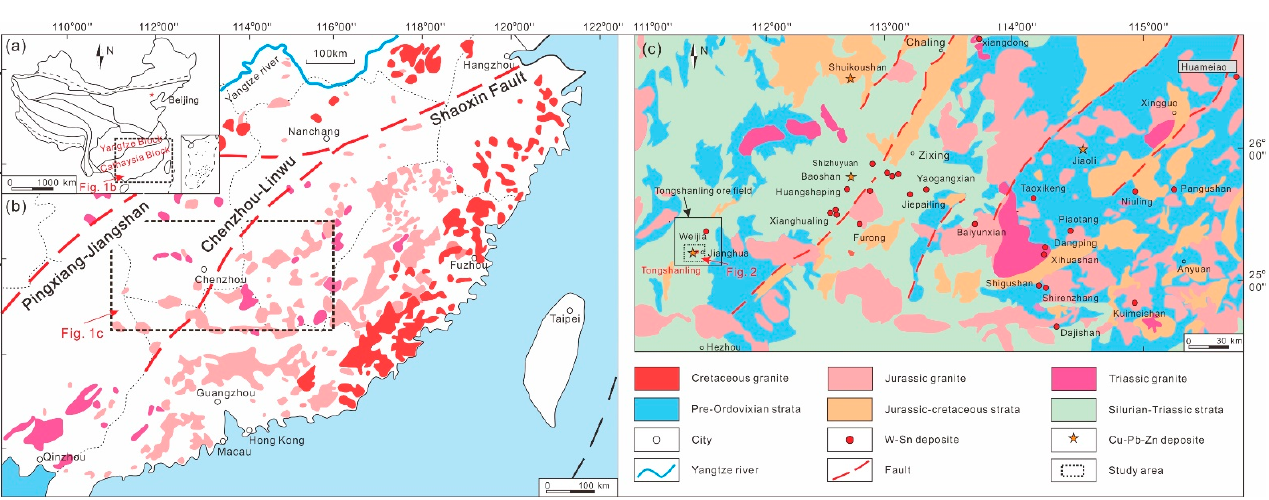
Figure 1. ( a ) Plate Tectonic Map of China. ( b ) Location of South Hunan district in the Qin-Hang Belt and the Nanling Region, modified from [16,17]. ( c ) Geologic map of Nanling metallogenic belt, modified from [11].